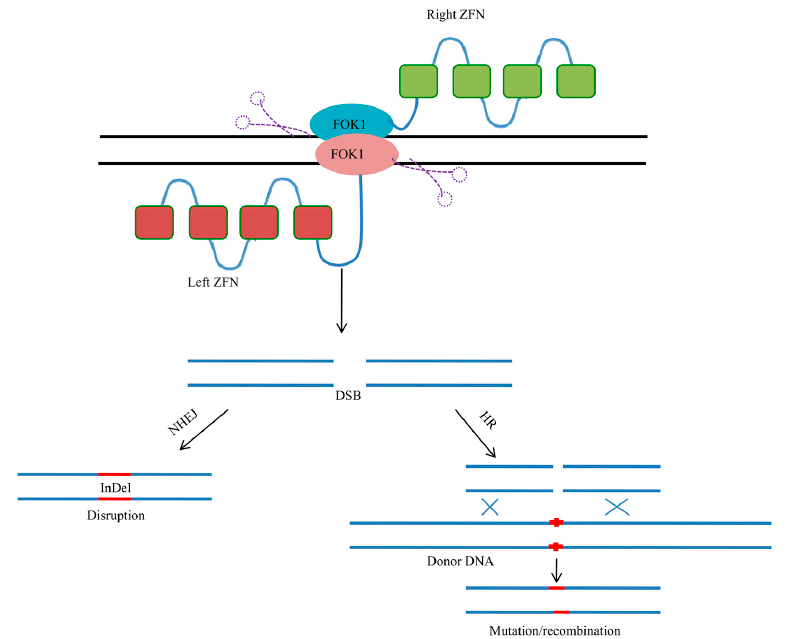
Figure 2. Schematic representation of Zinc finger nucleases (ZFNs). ZFNs constitute FOK1 nuclease domain at the carboxyl end and a Zinc finger protein at the amino terminus. FOK1 nuclease creates double stranded breaks (DSB), which repaired by nonhomologous end joining (NHEJ) or homologous recombination (HR) to bring desired mutation/recombination of gene.